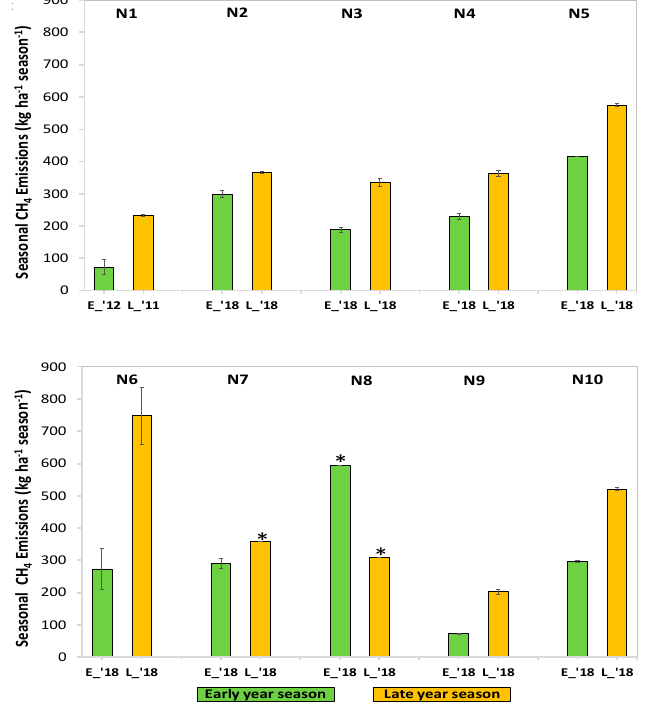
Figure 4. Seasonal CH 4 emission rates (kg ha − 1 season − 1 ) of field measurements in North Vietnam; standard errors among three replicates shown as error bars or marked by asterisks if not available. Crops are shown in sequential order which does not always correspond to the chronological order shown in Figure 2. Table 1. Field measurements of daily CH 4 emission rates and cultivation period in North Vietnam. For site locations, refer to Figure 2; Cult. per.—cultivation period; error—standard error.